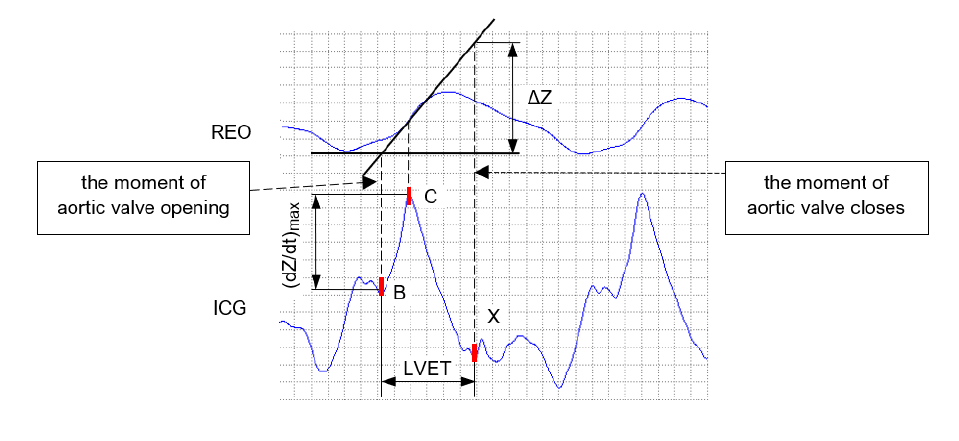
Figure 2. The way to determine a change in the bioimpedance during one cardiac cycle [58]. (cid:16) (cid:17) dZ The values of and LVET necessary to estimate the stroke volume SV can be dt max determined based on the positions of the characteristic points B , C , and X located on the first derivative of the bioimpedance curve (ICG) [58].